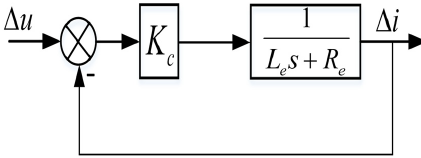
Figure 5. Current loop with proportional controller.